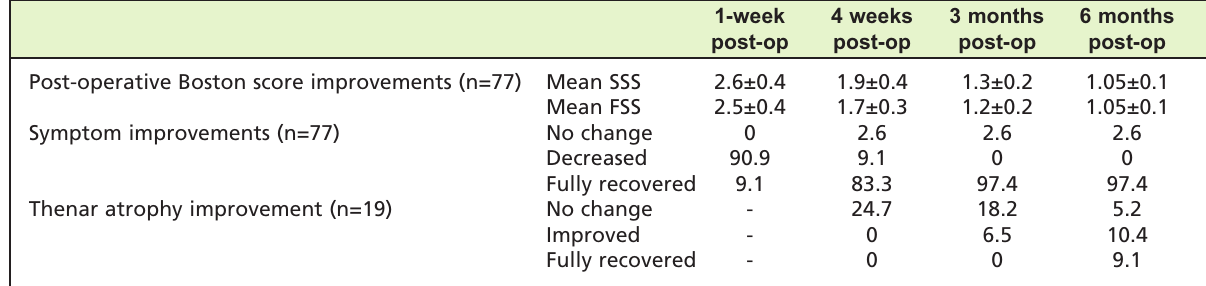
Electromyography improvements Table V: